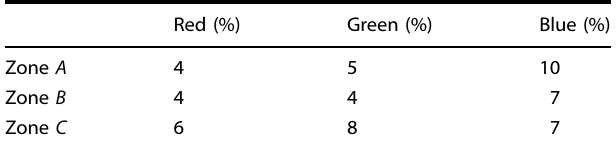
Table 2. Transmission reduction of FePS 3 fl akes preserved under ambient conditions for each RGB channel and measured at “ day 3 ” relative to “ day 0 ”